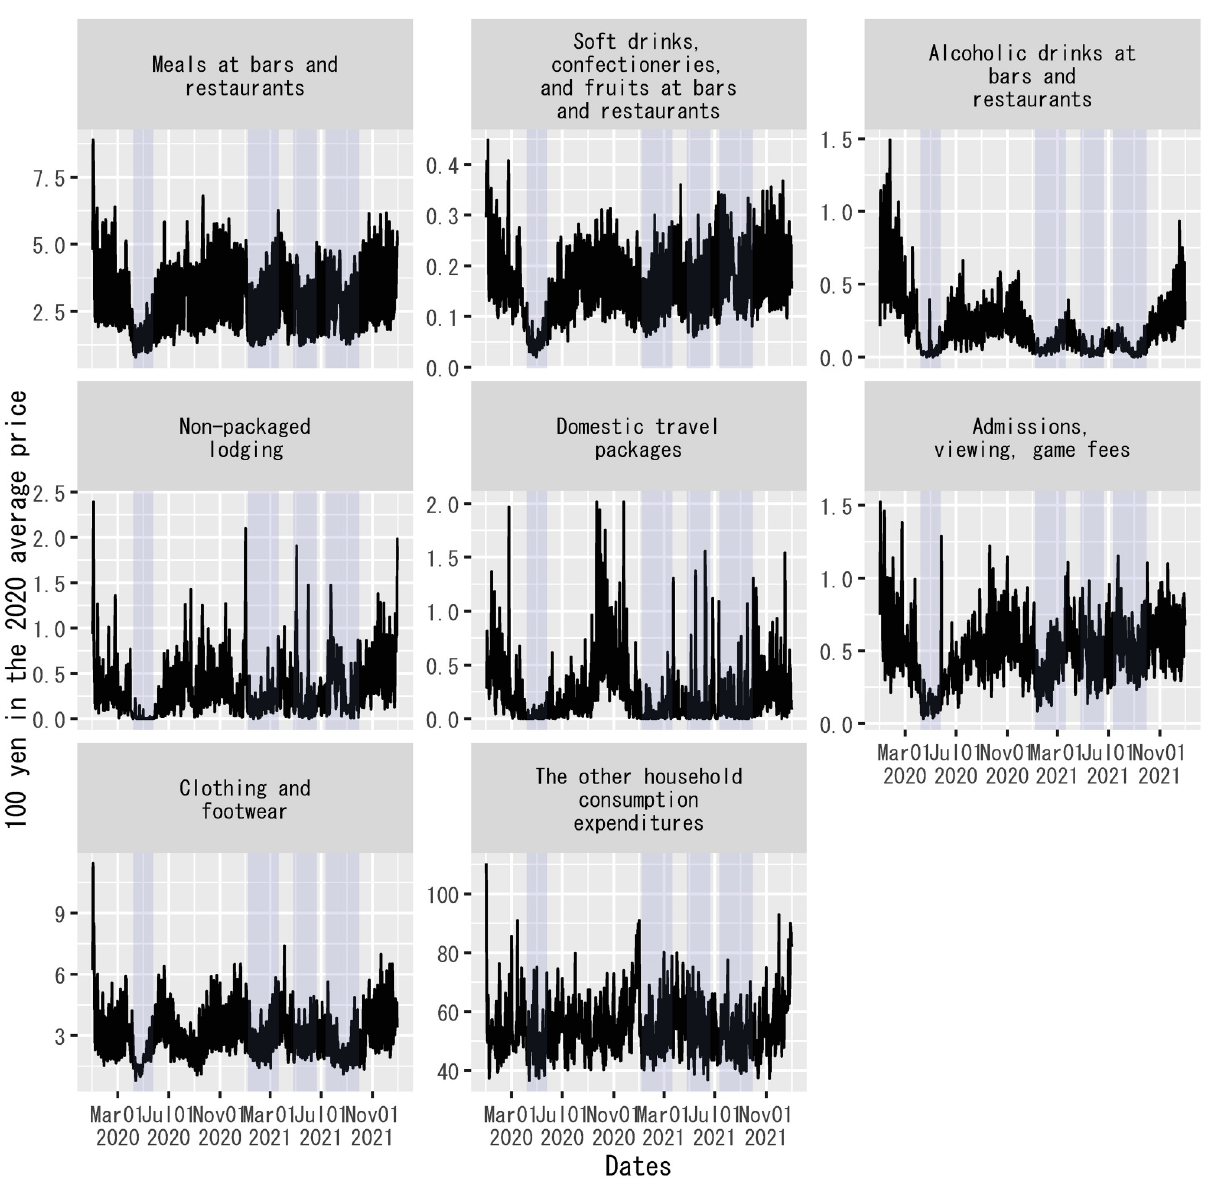
Fig 2. “Real” values of classified components of household expenditures per household in Japan. These series are computed by dividing each component of nominal household expenditures per household by the corresponding consumer price index on each date. They are used for explanatory variables in the regression model. The unit of each series is normalized to 100 yen at the average price of each component of household expenditures in 2020. The sample period shown in the figure is from January 1, 2020, to December 31, 2021. Each shadowed period indicates a state of